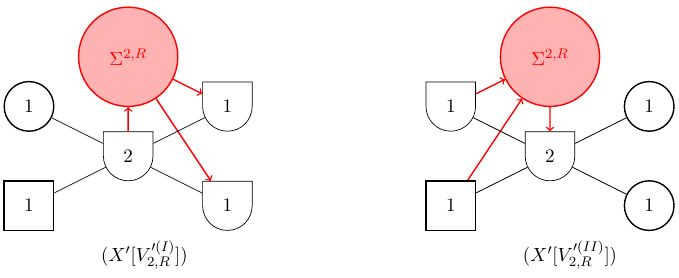
in the D quiver 4 2 ,R